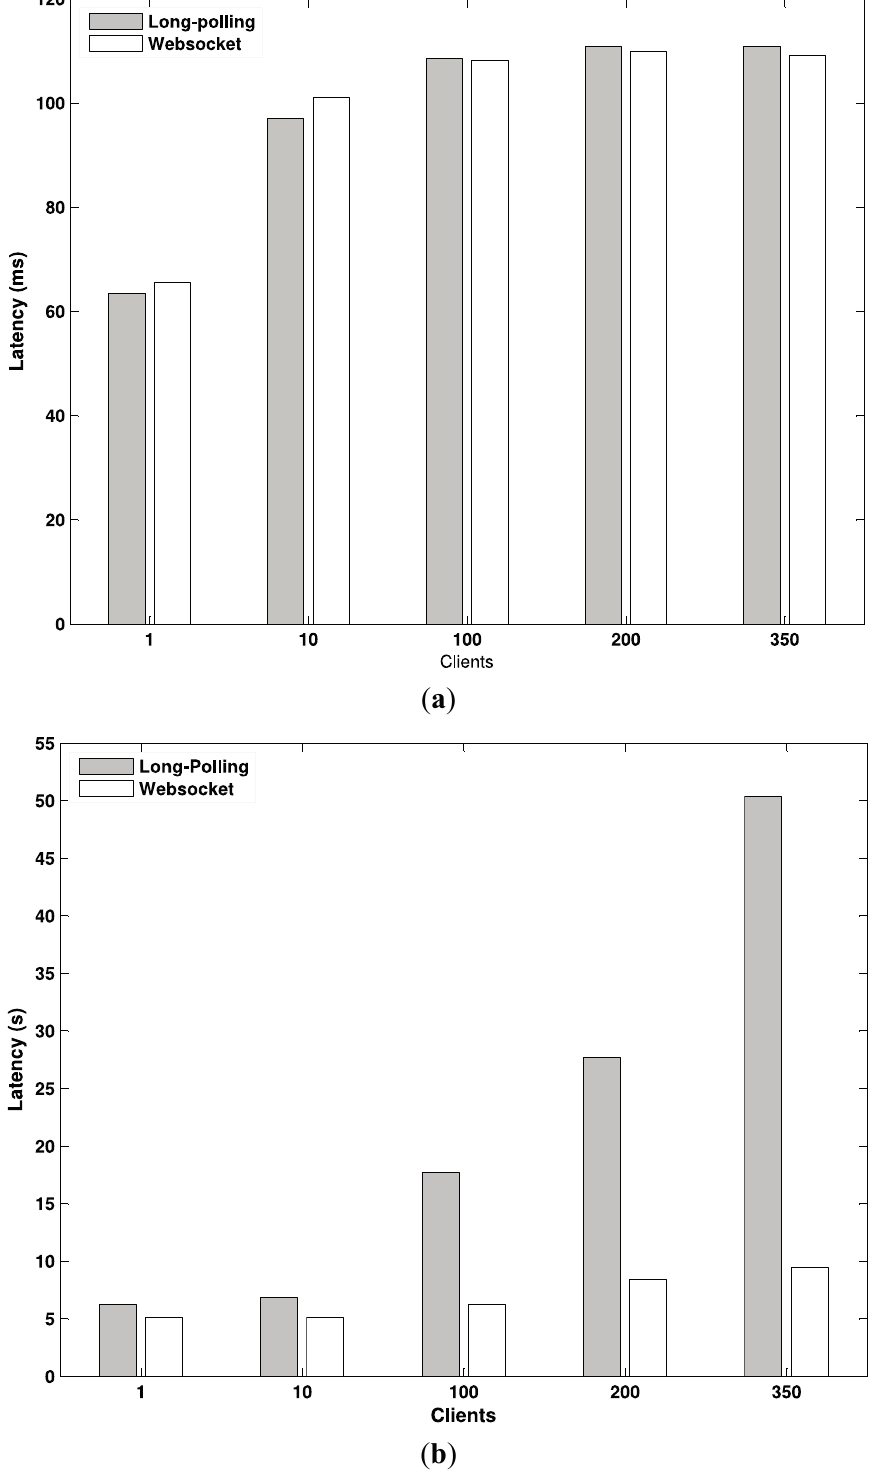
Figure 14. Latency for short and long lived communications. The CoAP proxy benefits from the use of WebSocket in long-lived communications. ( a ) Latency for short-lived communications; ( b ) Latency for long-lived